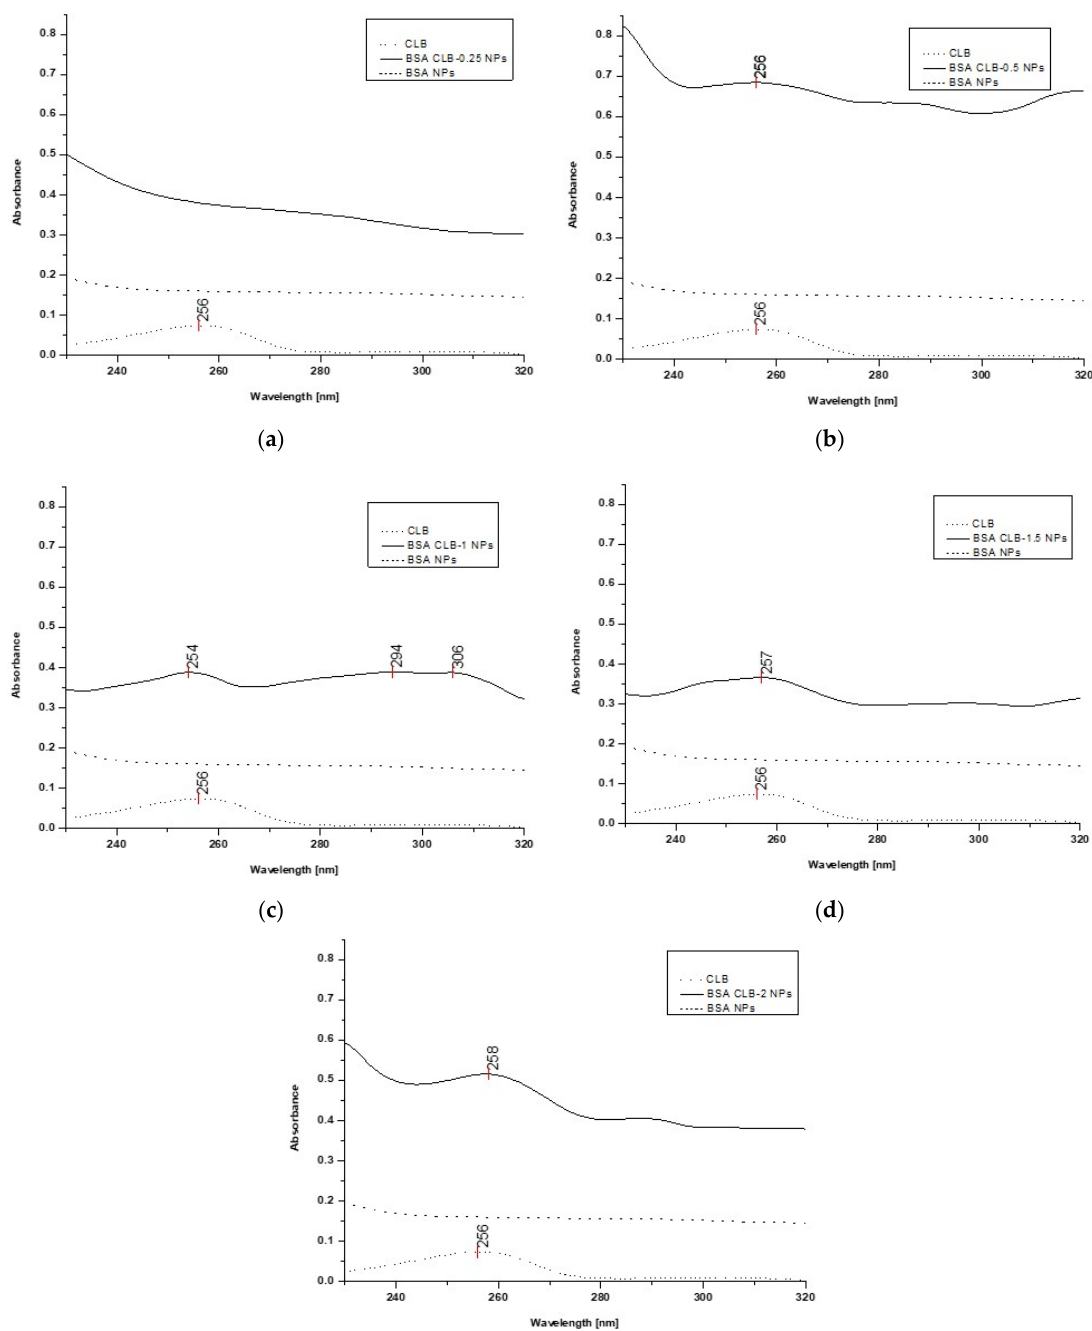
Figure 5. UV spectra: ( a ) free CLB, BSA CLB ‐ 0.25 NPs and BSA NPs; ( b ) free CLB, BSA CLB ‐ 0.5 NPs and BSA NPs; ( c ) free CLB, BSA CLB ‐ 1 NPs and BSA NPs; ( d ) free CLB, BSA CLB ‐ 1.5 NPs and BSA NPs; ( e ) free CLB, BSA CLB ‐ 2 NPs and BSA NPs. As shown in Figure 4a, BSA CLB ‐ 0.25 NPs is the only group where CLB emission is characterized by the shift toward the shortwave region (blueshift). The BSA CLB ‐ 0.5 NPs sample (Figure 4b) exhibits no shift in the spectrum for CLB, while BSA CLB ‐ 1 NPs, BSA CLB ‐ 1.5 NPs and BSA CLB ‐ 2 NPs (Figure 4c–e) show significant shifts toward the longwave region for CLB fluorescence band (redshift). The blueshift of the CLB emission band is probably associated with the successful entrapment of the drug at the nanoparticle preparation stage. In contrast, the redshift occurs most probably due to the presence of CLB molecules on the surface of nanoparticles or between fragments of polypeptides final shift of the CLB band. The spectrum of BSA NPs was recorded as a reference. As nm is insignificant in this case. The CLB absorption spectrum (control) exhibits one band at 256 nm. Based on the spectra presented in Figure 5a–e, overlapping peaks of CLB in the BSA CLB ‐ 0.5 NPs, BSA CLB ‐ 1 NPs, BSA CLB ‐ 1.5 NPs and BSA CLB ‐ 2 NPs systems are observed. The BSA NPs and BSA CLB ‐ 0.25 NPs samples do not show any well ‐ defined absorption bands. The lack of significant peak (associated with the presence of CLB) for the BSA CLB ‐ 0.25 NPs system probably results from the low concentration of the drug. The spectra presented in Figure 5c (BSA CLB ‐ 1 NPs) show additional peaks at 294 and 306 nm, which are probably related to the presence of modified albumin or various changes in the structure of the albumin chain during the nanoparticle formation. The fluorescence emission spectrum recorded for the BSA CLB ‐ 0.25 NPs system ex ‐ hibits strongly blueshifted signals (Figure 4a) while no significant shift is observed on the UV spectrum (Figure 5a). Comparison of these two methods may suggest that the CLB w encapsulated into the core of nanoparticles, but the amount of entrapped drug is too low; therefore, the encapsulation process caused no significant peak on the UV spectrum. The maximum in fluorescence emission and absorption spectra of BSA CLB ‐ 0.5 NPs and CLB (Figures 4b and 5b) overlaps, which simply suggests polymer–drug interaction. Release profile and R 2 values for samples of BSA CLB ‐ 1 NPs, BSA CLB ‐ 1.5 NPs and BSA CLB ‐ 2 NPs suggest zero ‐ order kinetics of release.